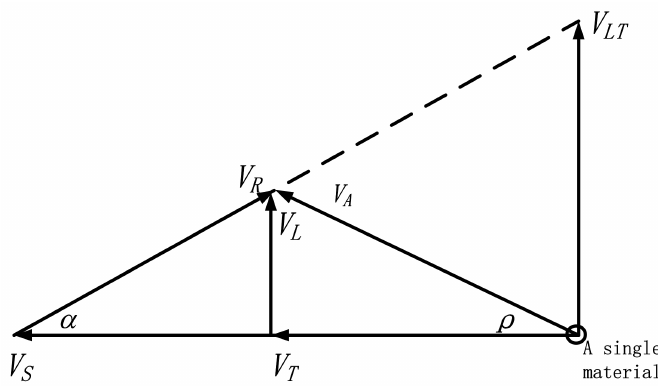
Figure 5. Diagram of the velocity of a single